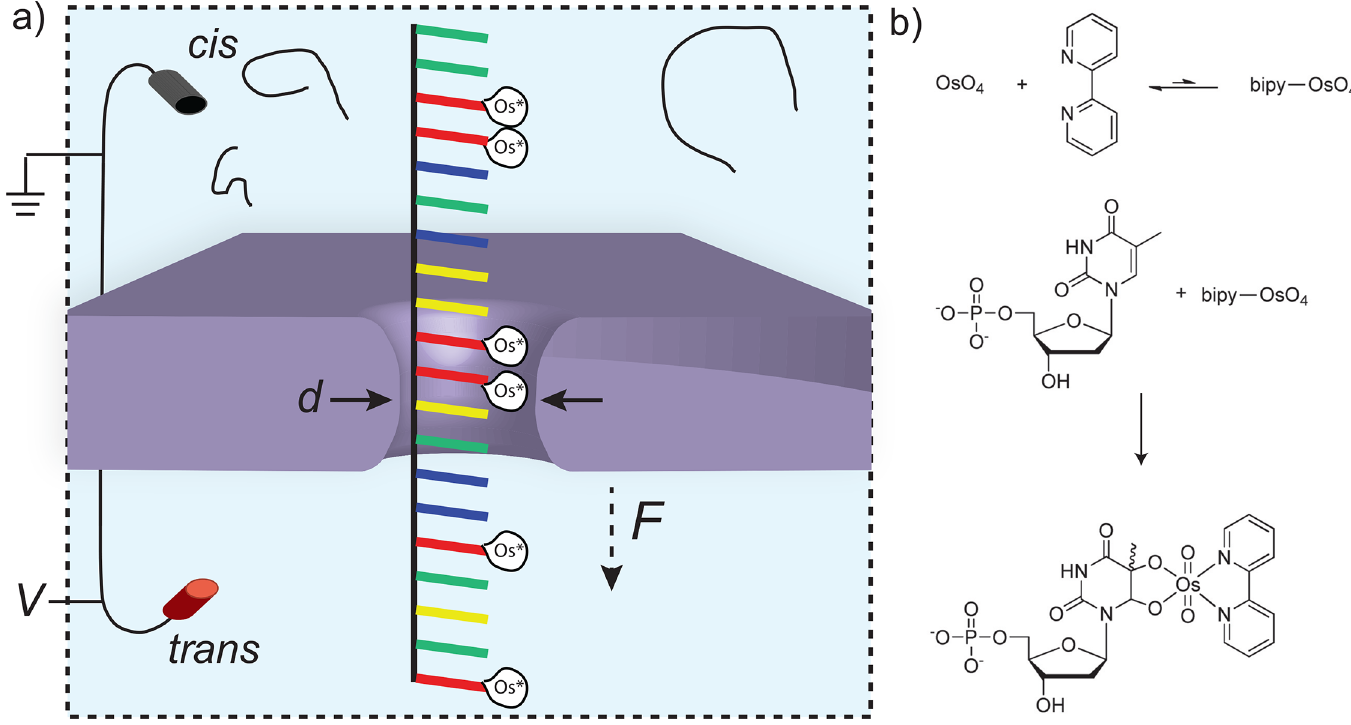
Fig 1. Solid-state nanopore detection of osmylated bases. (a) Schematic view of the nanopore ssDNA detection system. Voltage is applied across a SiN membrane containing a ~1.6 nm diameter nanopore using a pair of electrodes, leading to a steady-state ion current across the pore. When negatively charged DNA molecules are added to the cis chamber they are electrophoretically drawn through the nanopore to the positively charged electrode in the trans chamber. “ Os * ” tags are shown to represent osbipy molecules as they preferentially bind to thymidine bases (represented in red). (b) Reaction of OsO 4 with bipyridine to form the bipy-OsO 4 reactive complex. The complex then reacts with dTMP to form the osmylated adduct.